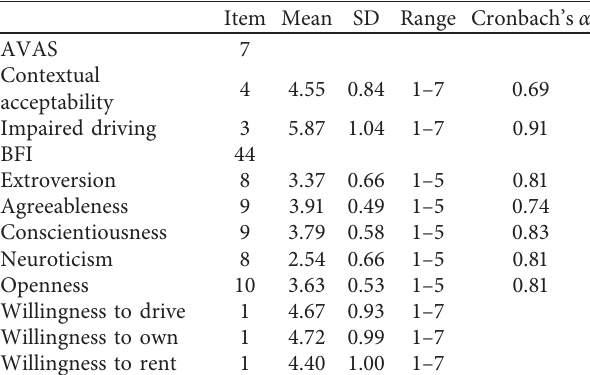
Table 3: Descriptive statistics for all the